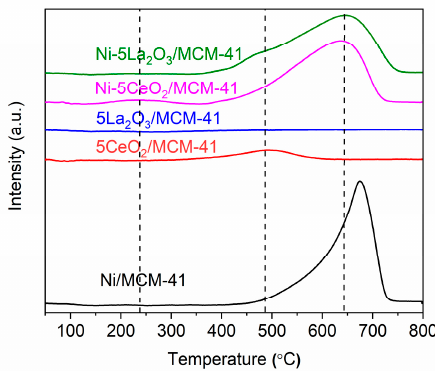
Figure 6. The H 2 -temperature-programmable reaction (TPR) profiles of the synthesized Figure 6. The H 2 ‐ temperature ‐ programmable reaction (TPR) profiles of the synthesized catalysts.